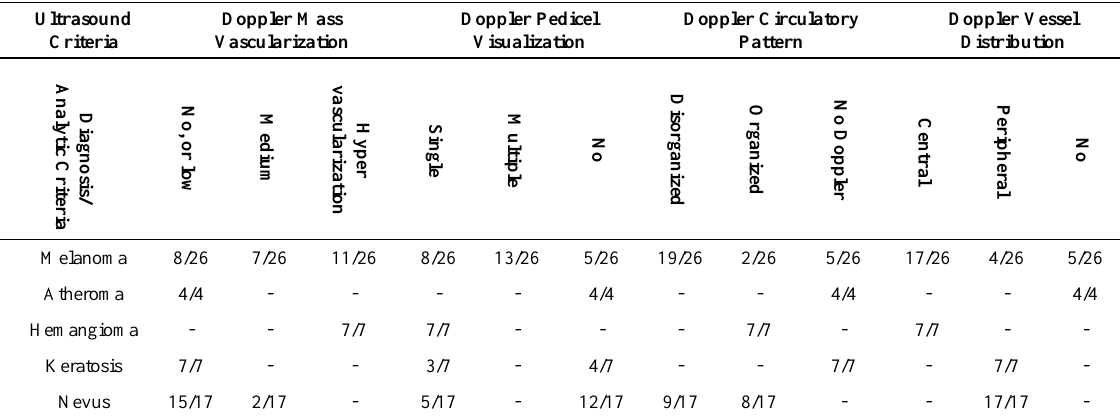
Doppler Mass Vascularization